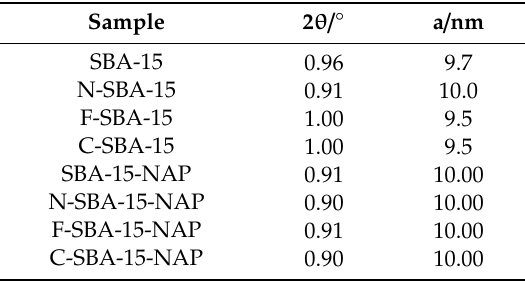
Table 2. Unit cell parameters of the studied silica materials.